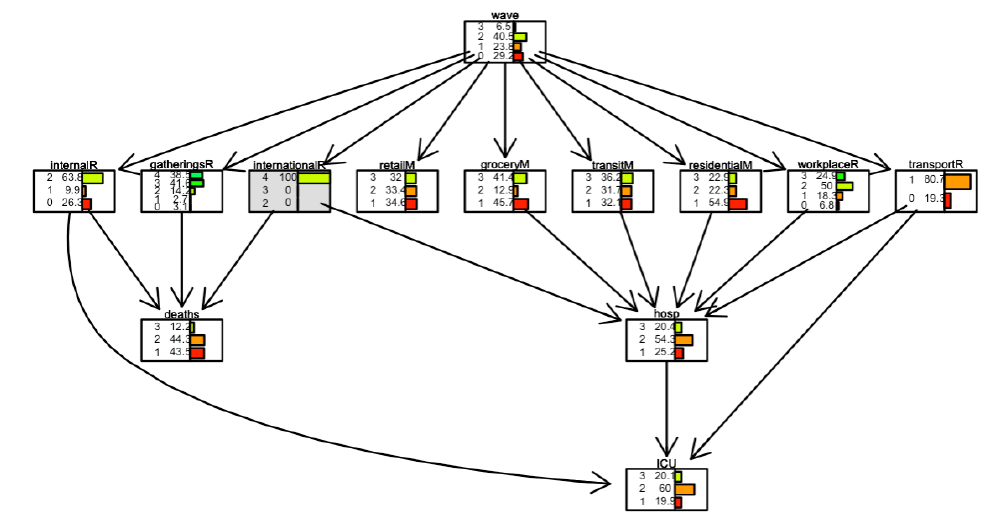
Figure 21. Scenario for Israel when international movements restriction is set to 4. The international movement restriction node is highlighted in grey.